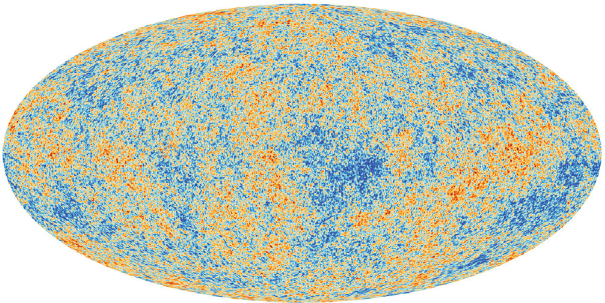
FIG. 1. Image of the cosmic microwave background. This is the faint glow left over from when the Universe was around 380 000 years old. This representation was created based on data from the Planck satellite. Image credit: ESA/Planck